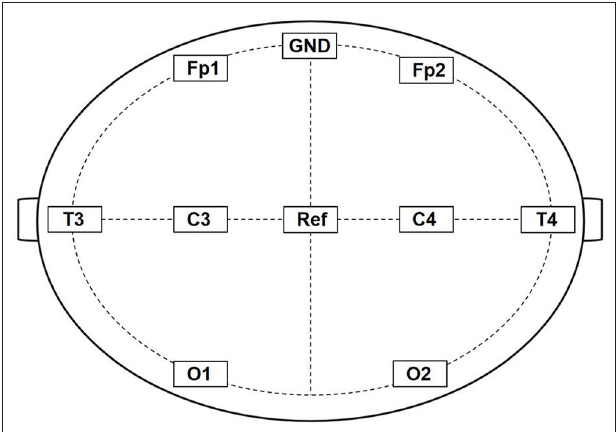
FIGURE 1 | Schematic diagram of 8-channel cortex electrodes EEG. Fp1, T3, C3, and O1 are fixed to the frontal, temporal, parietal, and occipital lobes of the left hemisphere, whereas Fp2, T4, C4, and O2 are fixed to the frontal, temporal, parietal, and occipital lobe of the right hemisphere, respectively. GND was connected to an electrical ground and Ref is the Reference electrode.